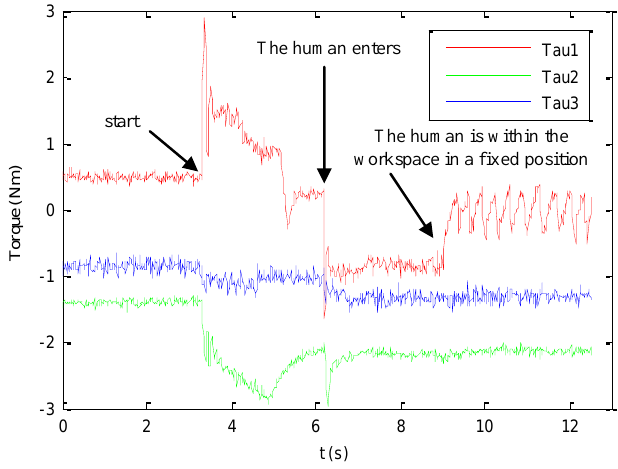
Figure 8. Torques employed to guide the mini-robot during the second